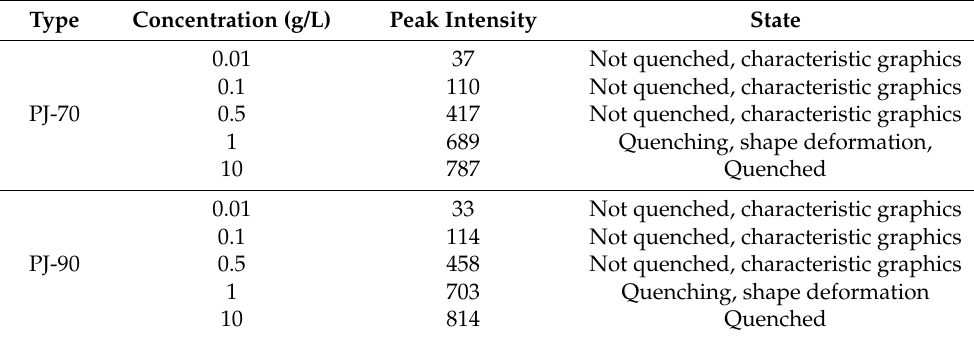
Table 1. Fluorescence quenching of bitumen diluent with different concentrations.